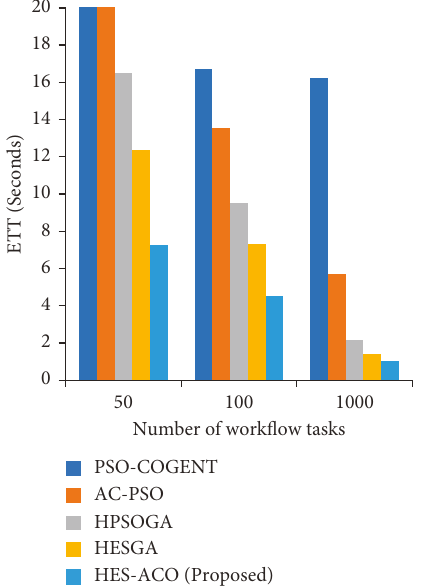
Figure 9: Execution time.